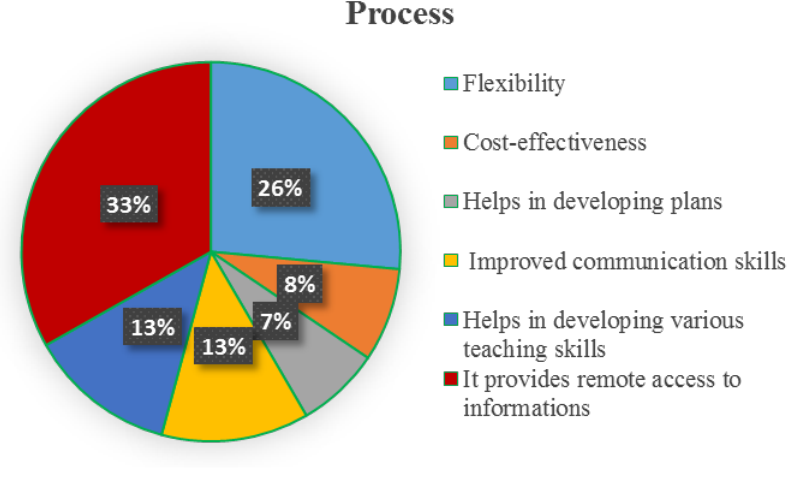
Figure - 3: Showing the effect of online learning on